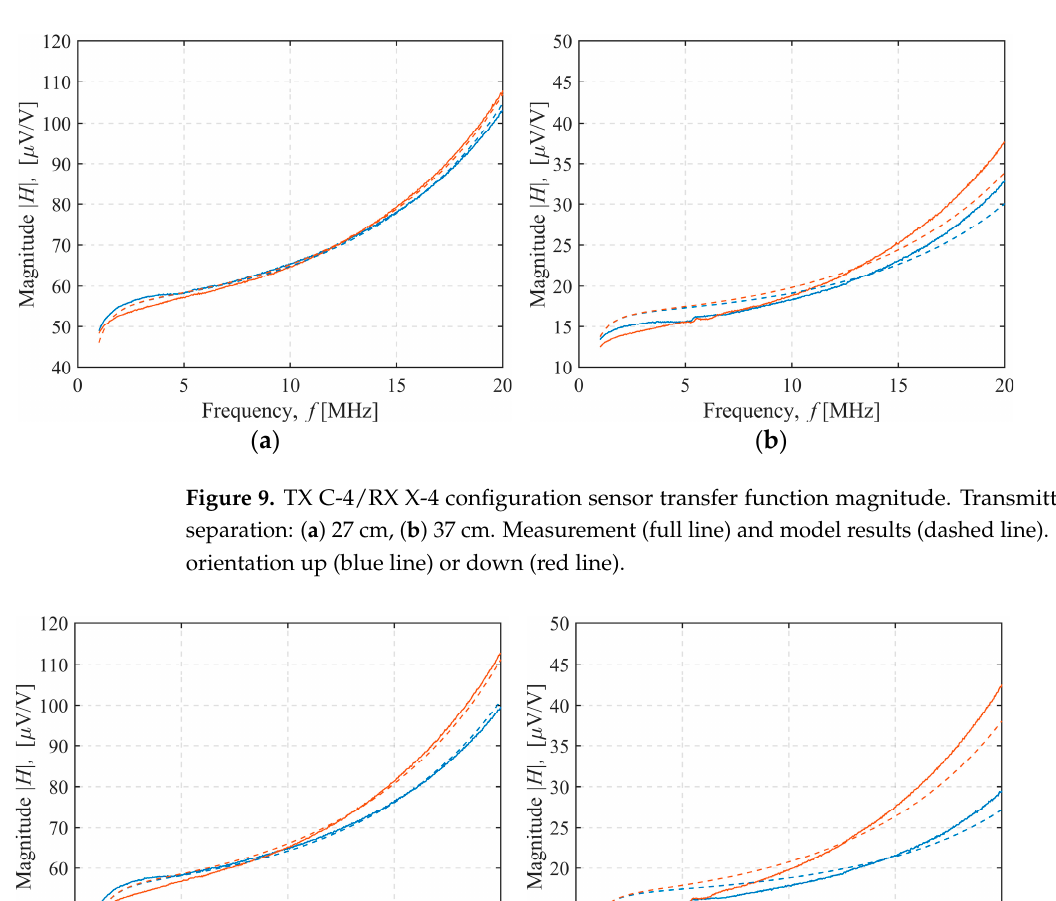
( b ) Figure 11. TX X-6/RX X-6 configuration sensor transfer function magnitude. Transmitter–receiver separation: ( a ) 27 cm, ( b ) 37 cm. Measurement (full line) and model results (dashed line). Transmit- ter orientation up (blue line) or down (red line). 3.4. Shield Effectiveness Validation in the Presence of Conductive Medium To demonstrate the effect of shielding, the sensor response was measured above a container filled with 60 L of saline water with an electrical conductivity of 1 S/m and a dielectric permittivity of 78, as shown in Figure 12. The saline water was used to emulate the soil because it has similar electromagnetic properties, and allowed for easier control of the electrical conductivity. First, the response of the sensor in the air was measured and then the response above the saline water was measured. Two different shield configura- tions were evaluated (TX C-2/RX C-2 and TX X-6/RX X-6). The intercoil separation was 27 cm and the sensor lift-off above the saline water was 11 cm with respect to the transmitter. The experimental setup and instrumentation were the same as in Section 2.1. The measurement results were compared with the 3D full-wave finite element method (FEM) analysis using the CST studio suite 2021 software (Dassault Systèmes Sim- ulia) [23]. The FEM model, equivalent to the measurement setup geometry, is shown in Figure 13. The transmitter and receiver coils, shown in Figure 14, were modeled as a su- perposition of individual coil loops. The saline water was modeled as a homogeneous medium with dimensions of 58.3cm × 37.2cm × 28.3 cm, the electrical conductivity of 1 S/m and dielectric permittivity of 78. To simulate the sensor response in air, the medium parameters were set to an electric conductivity of 0 S/m and dielectric permittivity of 1. The boundary of the FEM model was set at 100 cm from the medium. The mesh grid con- sisted of 580,133 elements.